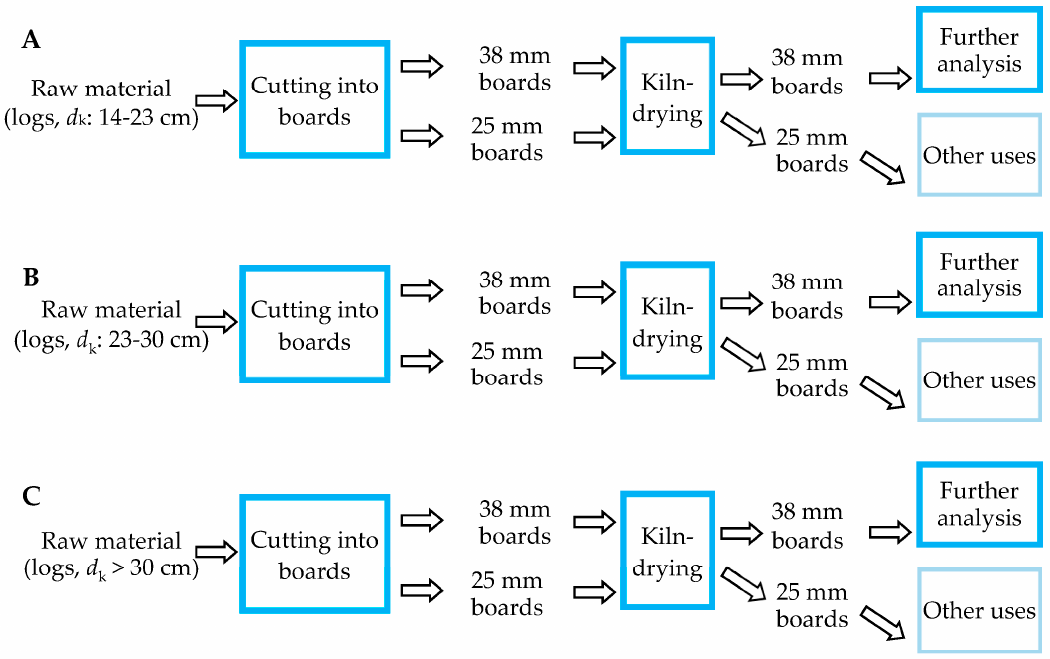
Figure 4. The analyzed variants of the first stage of wood processing (producing the specialized lumber as 38 mm board).